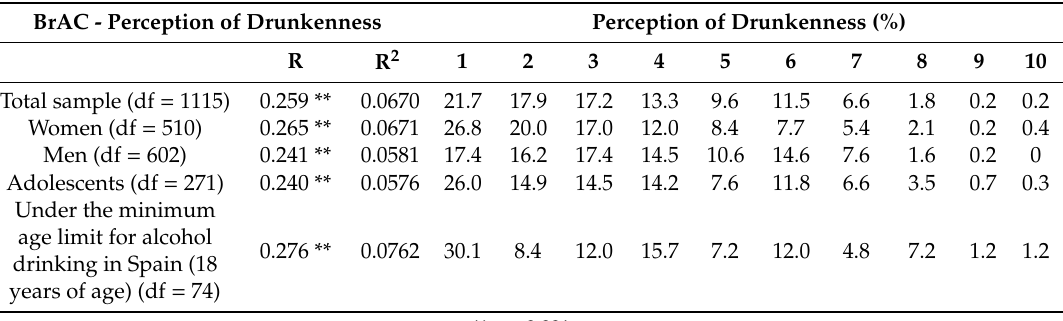
Table 6. Pearson correlation between BrAC scores and perception of drunkenness (in participants with BrAC > 0 and controlling by minutes in drinking environment) and proportion of participants who indicated the di ff erent answers in perception of drunkenness. BrAC - Perception of Drunkenness